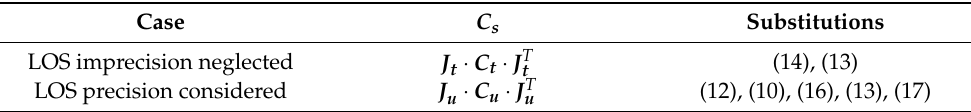
Table 2. Summary of the evaluation of covariance matrix C s